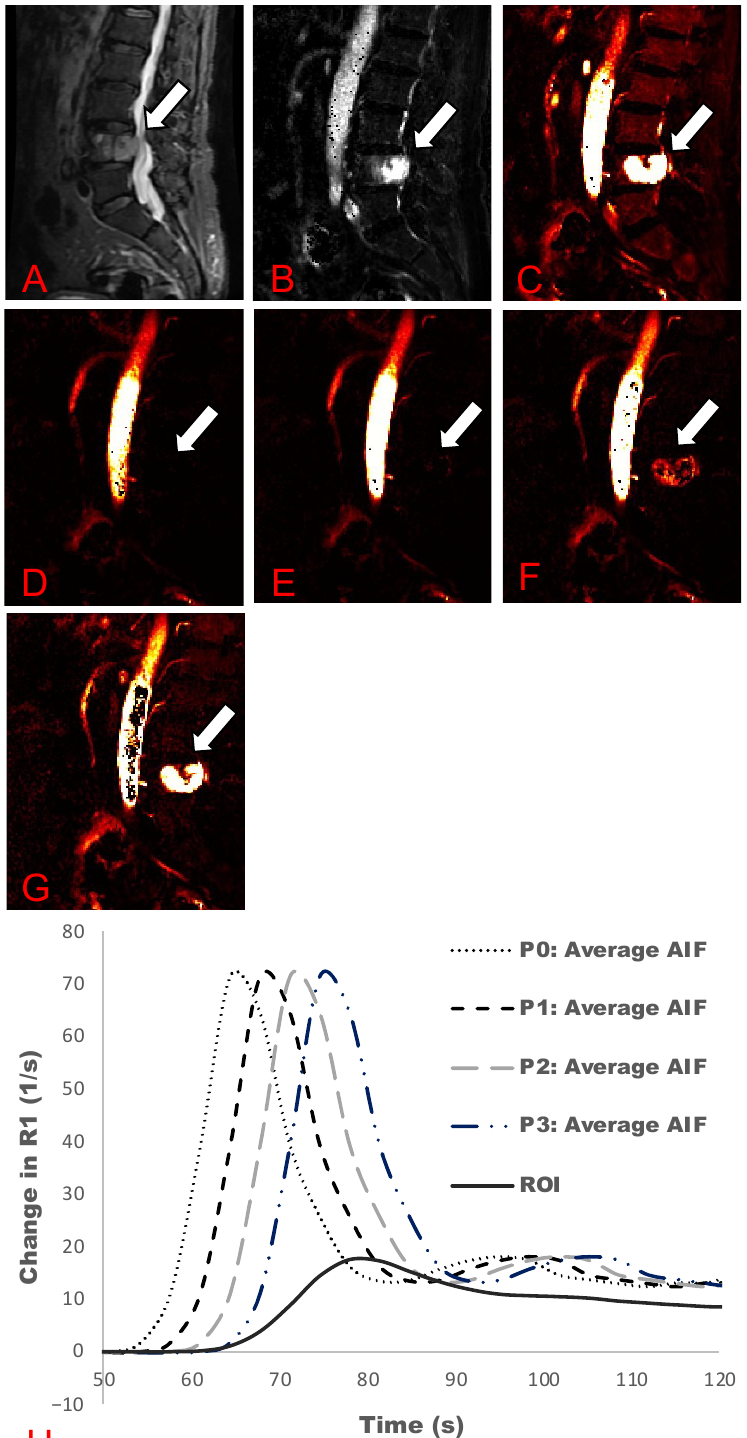
Figure 2. Active metastasis in L4 (Table 1: Patient 13). Multiple phase-shift delays and associated plasma volume (V p ) maps are presented. ( A ) STIR map; ( B ) Contrast uptake map; ( C ) K trans map; ( D ) V p maps without a phase-shift delay; ( E ) one phase-shift delay; ( F ) two phase-shift delays; and ( G ) three phase-shift delays. ( H ) AIF graph demonstrating the phase-shift delays at zero (P0), one (P1), two (P2), and three (P3) phase shifts of the average AIF curve. Solid line demonstrates the lesion ROIs.